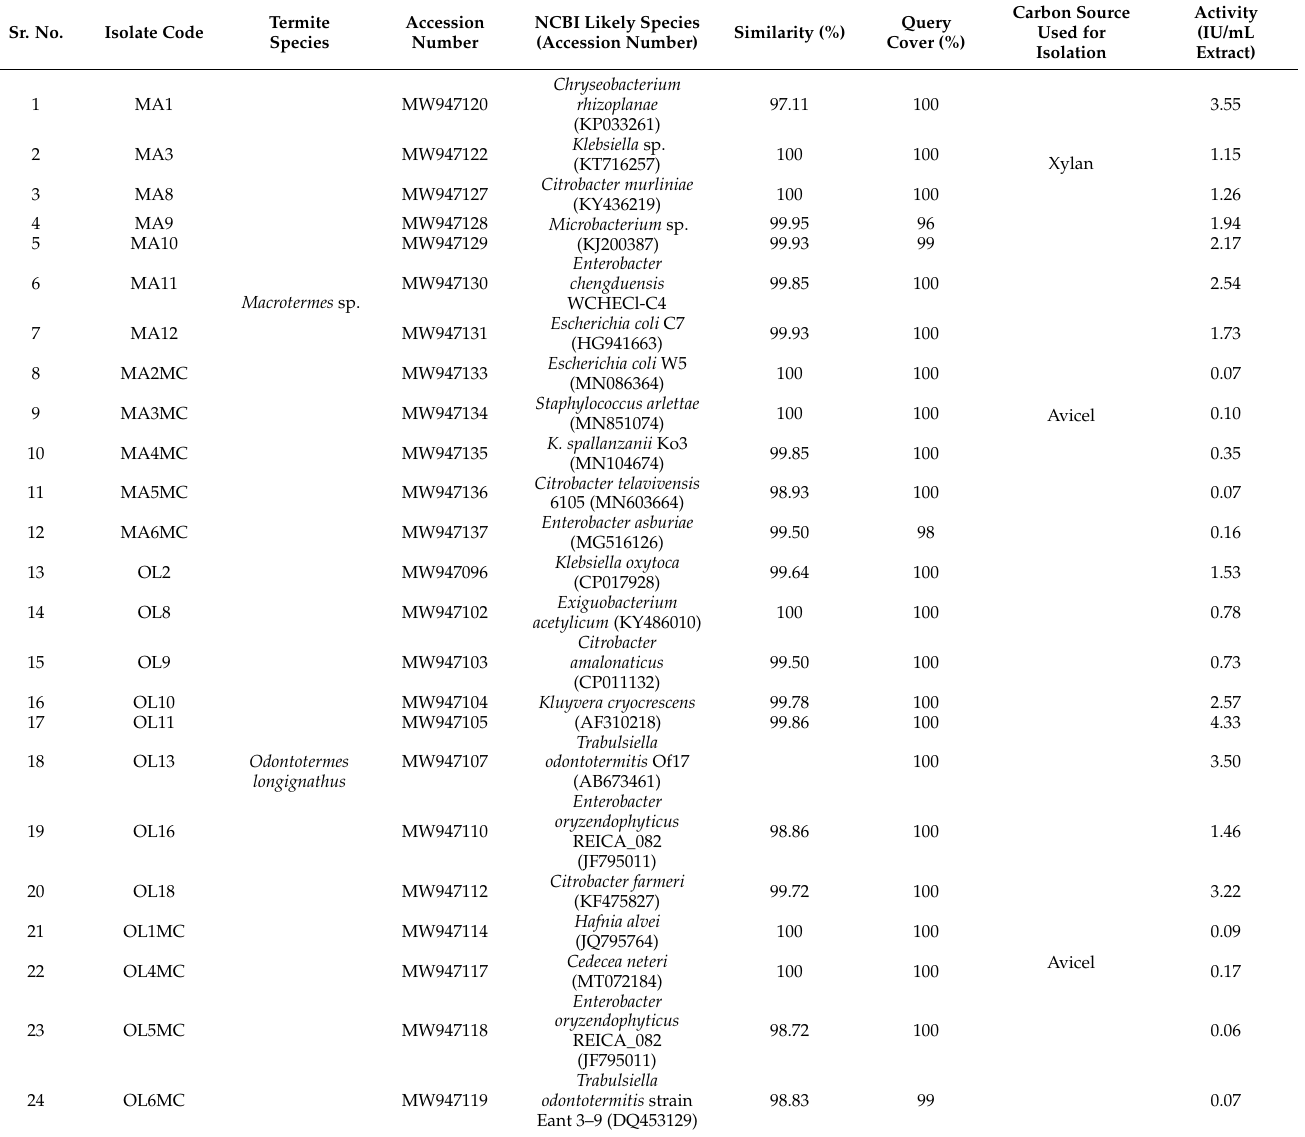
Table 2. A detailed account of the identification, source, and activity of the lignocellulolytic isolates along with their percent similarity of the corresponding 16S rDNA genes to closely related NCBI bacterial species determined by BLASTn